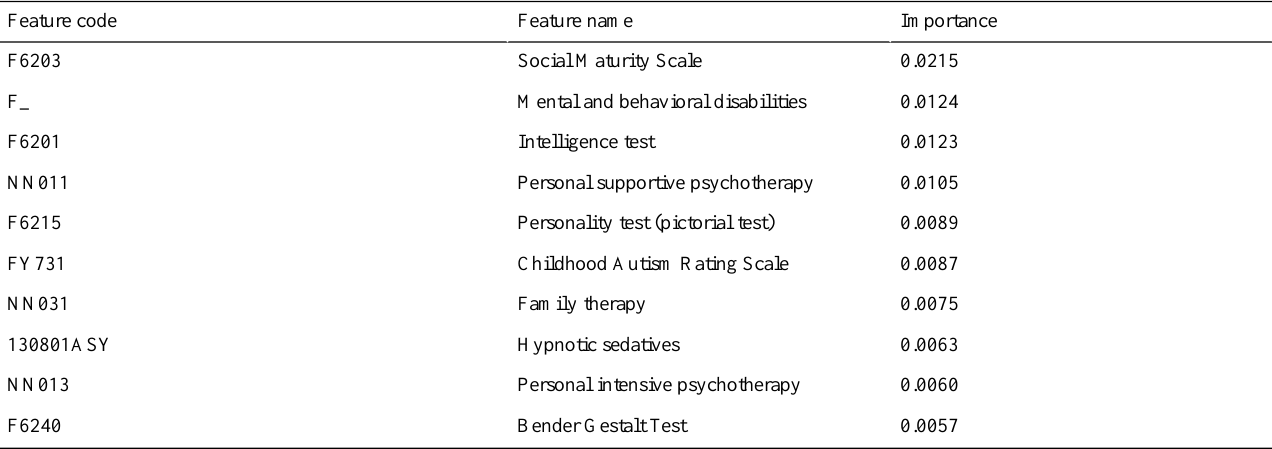
Table 6. Top 10 features in terms of importance when using disease diagnostic and prescription